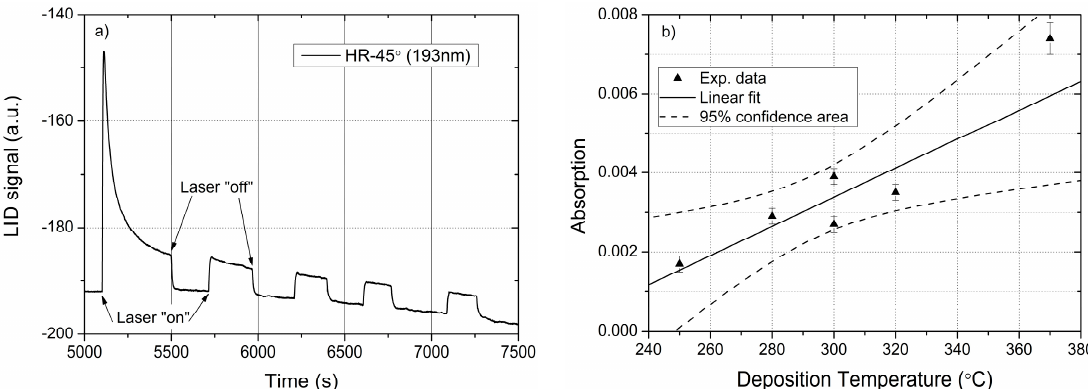
Figure 6. ( a ) Laser induced absorption decrease in HR coatings (MgF 2 /LaF 3 ) upon initial ArF laser irradiation due to hydrocarbon desorption, ( b ) Increasing HR coating absorption with deposition temperature. Absorption data are obtained after complete hydrocarbon desorption. (Adapted from [18]. Copyright 2008 SPIE International.)